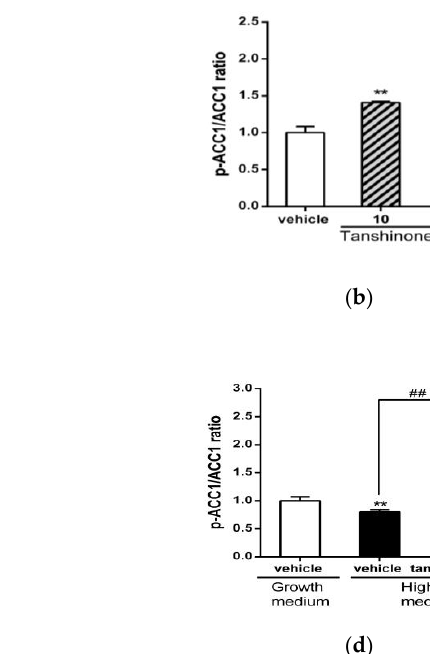
Figure 4. Effects of tanshinone IIA on ACC1 phosphorylation in HepG2 cells. ( a ) HepG2 cells were treated with vehicle (0.1% DMSO) or tanshinone IIA (5 and 10 µ M) in normal growth medium. The protein levels of phosphorylated ACC1 at serine 79 (p-ACC1), ACC1, and actin was measured by Western blot analysis. A representative blot is shown. ( b ) The normalized intensity of p-ACC1 protein versus ACC1 is presented as the mean ± SD of three independent experiments. ** p < 0.01 indicates significant differences compared to the vehicle-treated cells. ( c ) HepG2 cells were treated with vehicle (0.1% DMSO) or tanshinone IIA (10 µ M) in normal growth medium or high-fat medium. The phosphorylated ACC1 (p-ACC1), ACC1, and actin was measured by Western blot analysis. A representative blot is shown. ( d ) The normalized intensity of p-ACC1 versus ACC1 is presented as the mean ± SD of three independent experiments. ** p < 0.01 indicates significant differences compared to the vehicle-treated cells incubated with growth medium. ## p < 0.01 indicates significant differences compared to the vehicle-treated cells.